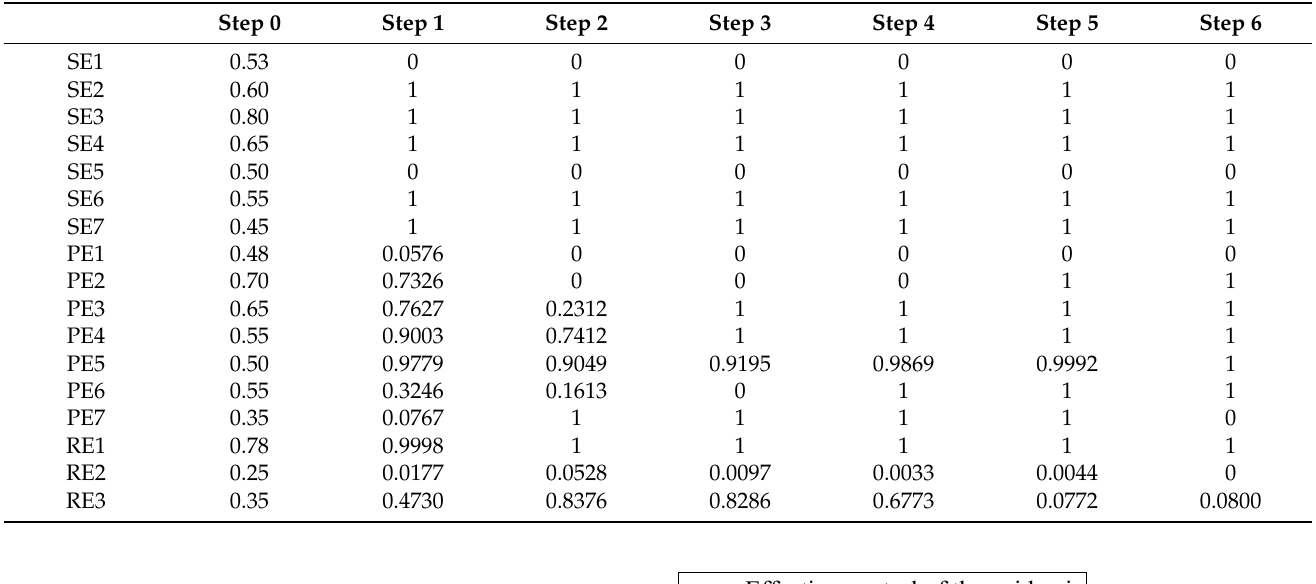
Table 16. Prediction probabilities for each scenario.